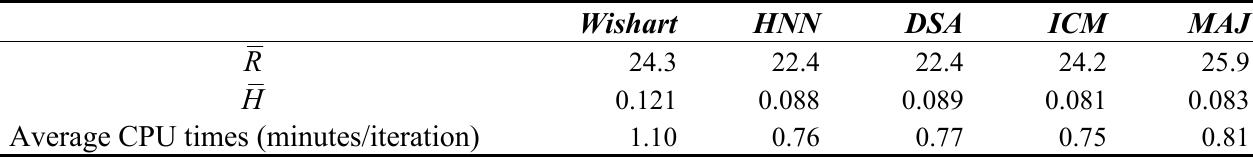
Average CPU times